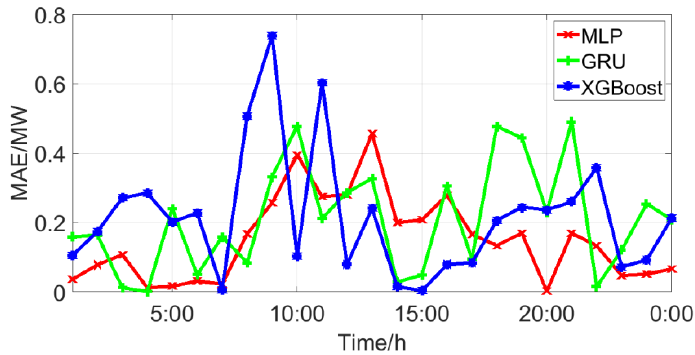
Figure 8. MAE values of the different models.